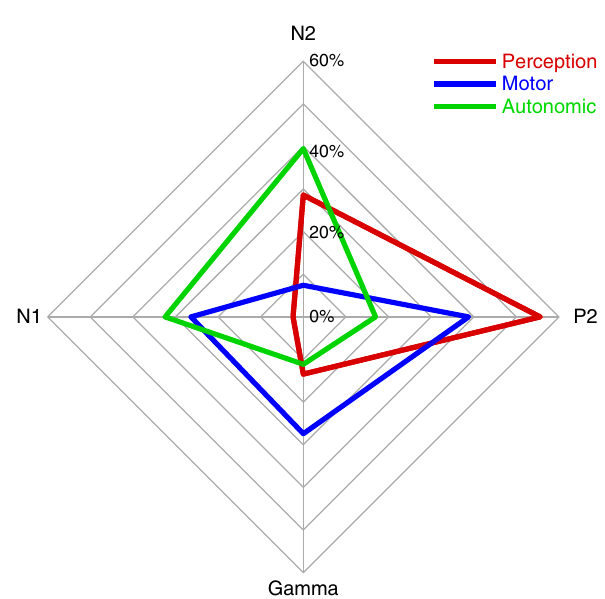
Fig. 6 Patterns of mediation effects in the different conditions. The radar chart depicts the relative mediation effect for each brain response and condition. The relative mediation effect of a brain response in a certain condition was calculated as the mediation effect divided by the sum of the mediation effects of all brain responses in that